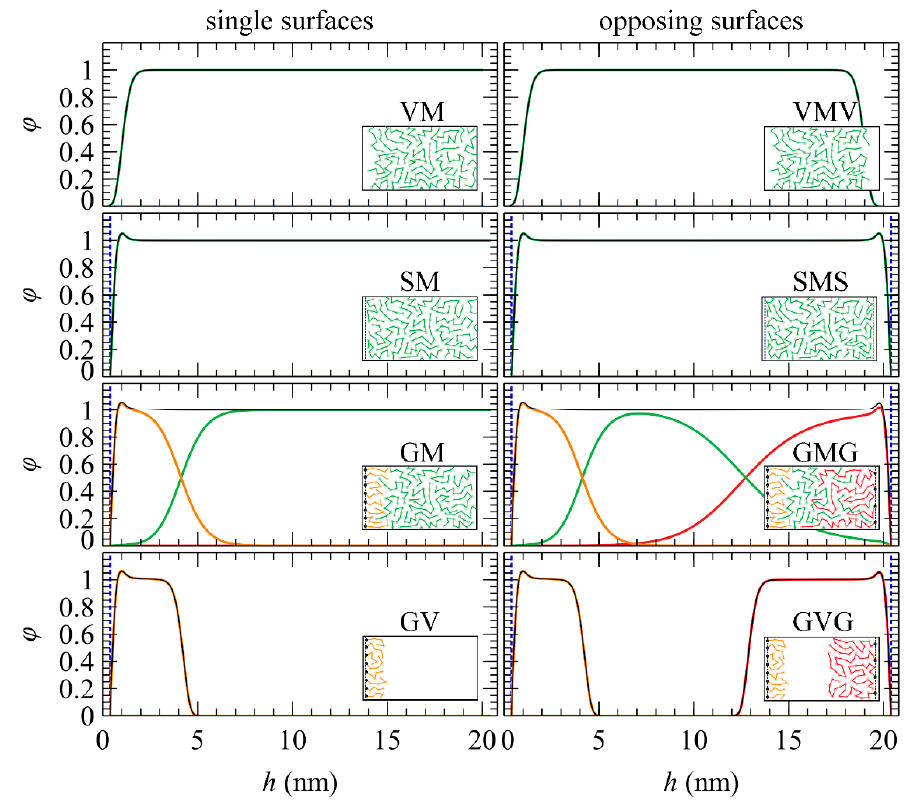
Figure 1. Density profiles of matrix (m, green) and grafted (g – , orange; g + , red) chains in planar configurations. The panels on the left/right correspond to single/opposing (VM/VMV) vacuum–matrix, (SM/SMS) solid–matrix, (GM/GMG) grafted–matrix, and (GV/GVG) grafted–vacuum interphases; V: vacuum, S: solid, G: grafted, and M: matrix. The insets depict representations of each system; the dots depict grafting points, and the vertical lines denote the Dirichlet, q c = 0 boundary. The polymer grafted surfaces (G) at the left and right boundaries exhibit grafting densities and grafted chain lengths equal to ( σ g − , N g − ) = (0.8 nm –2 , 50) and (0.4 nm –2 , 200), respectively. The distance between the boundaries of the domain was set to L = 20 nm. The matrix chains have a chain length equal to 100 monomers. The system corresponds to perfectly wetting polystyrene films with the hybrid Hamaker–ramp potential at a temperature equal to T = 500 K (see Table 1 in Ref. [27]).